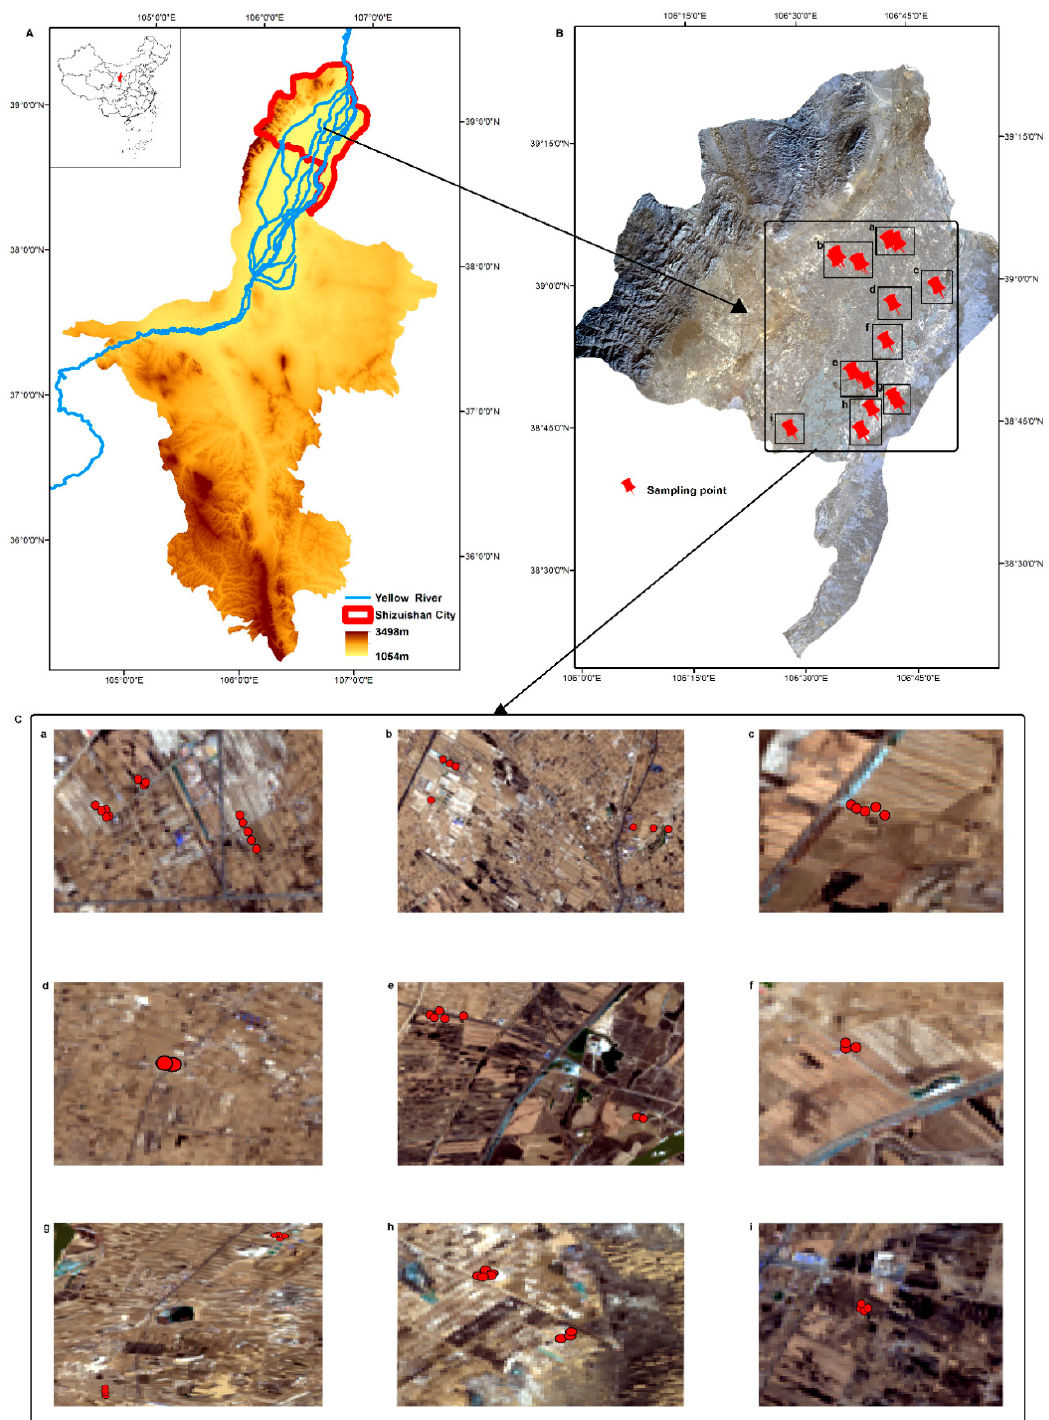
Figure 1. Study area and sampling location. ( A ) A Digital Elevation Model (DEM) diagram of the Ningxia Hui Autonomous Region, made using the original elevation data of the Shuttle Radar Topography Mission (SRTM) DEM 90-meter resolution data product. ( B ) The sampling location around the Yellow River Irrigation region in Shizuishan City, made from the Landsat 8 data of April 2018. ( a – i ) in B correspond one-to-one with (a–i) in ( C ) and show the specific position and surrounding conditions of the sampling point.